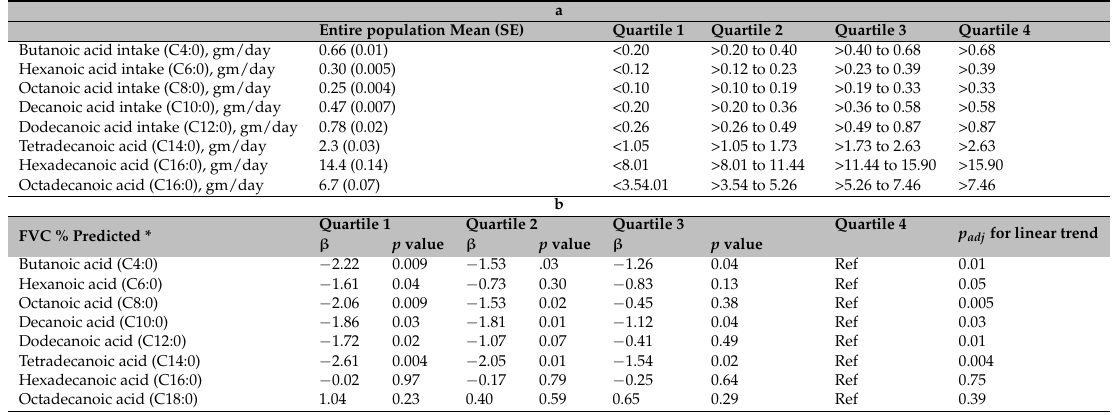
Table 3. ( a ) Ranges of intake of individual fatty acid by quartile for participants with airflow obstruction. ( b ) Results of multivariate regression analysis for the relationship between individual saturated fatty acids (SFA) intake and forced vital capacity (FVC) % predicted in individuals with chronic obstructive pulmonary disease